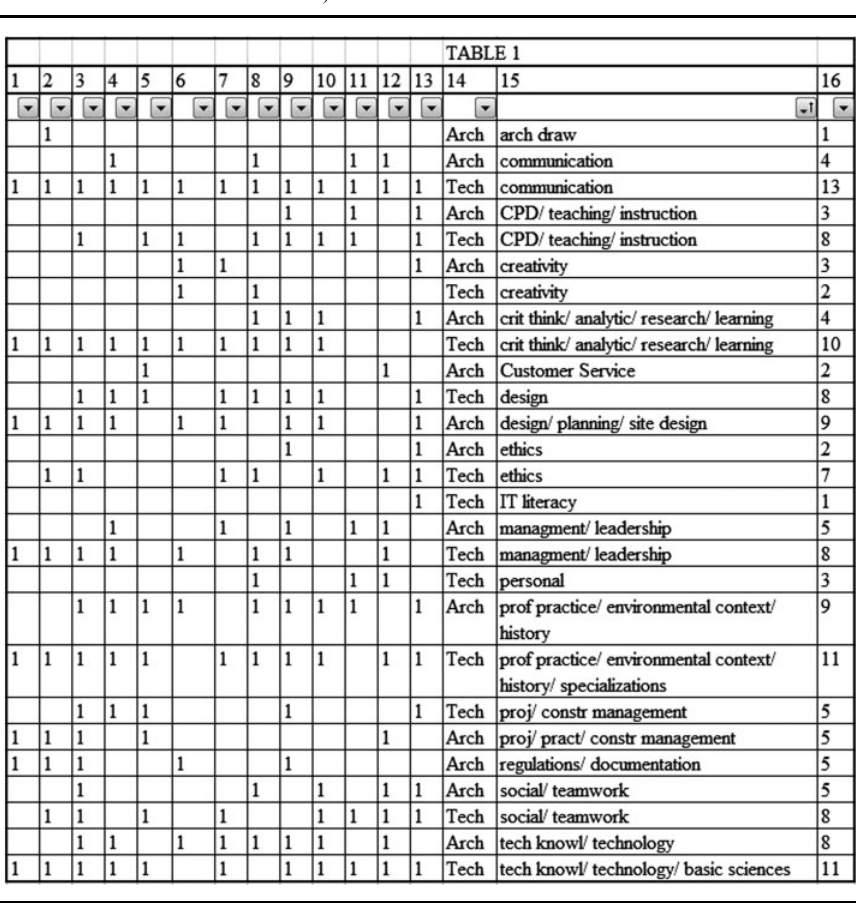
Table 1. Analysis of essential competences of Architecture and Technology (denoted in the Table as ‘Arch’ and ‘Tech’)